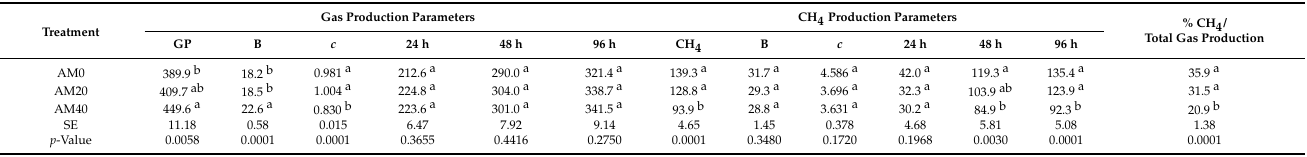
Figure 1. Gas ( A ) and CH 4 ( B ) production kinetics of diets with increasing levels of Acacia mearnsii. Table 4. Gas and CH 4 production parameters (mL/0.500 g fermentable DM) of diets with increasing levels of Acacia mearnsii (AM) .